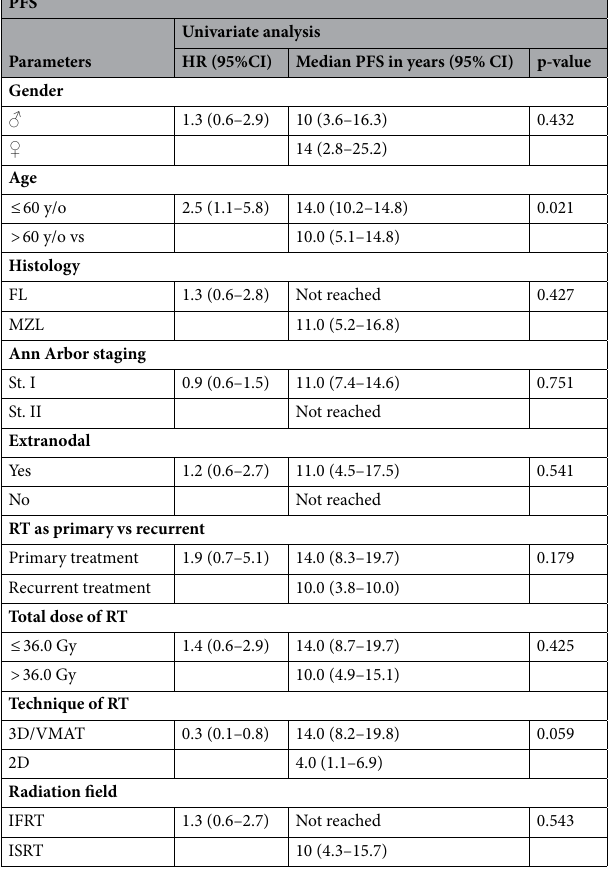
Table 3. Univariate analysis of PFS.